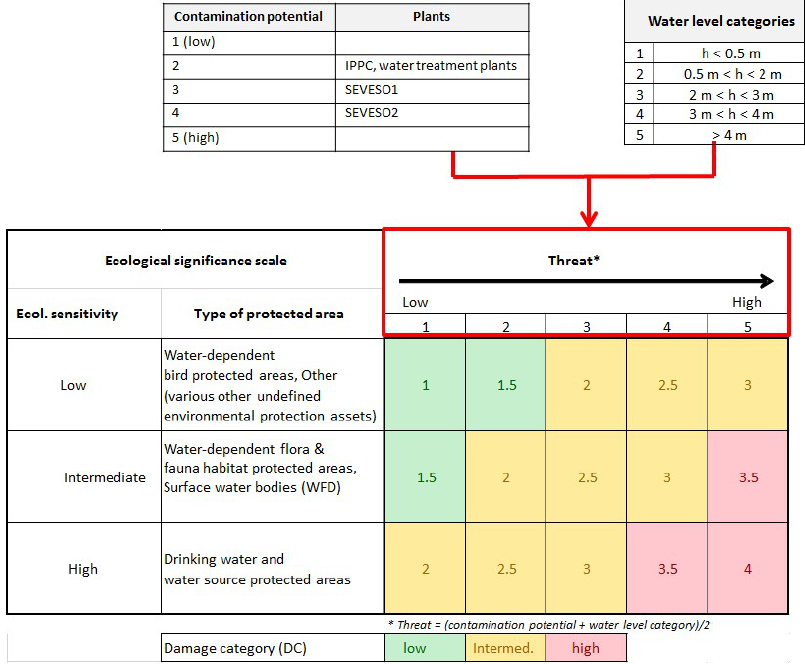
Figure 5. Approach for the analysis of damage to environment [7,8].